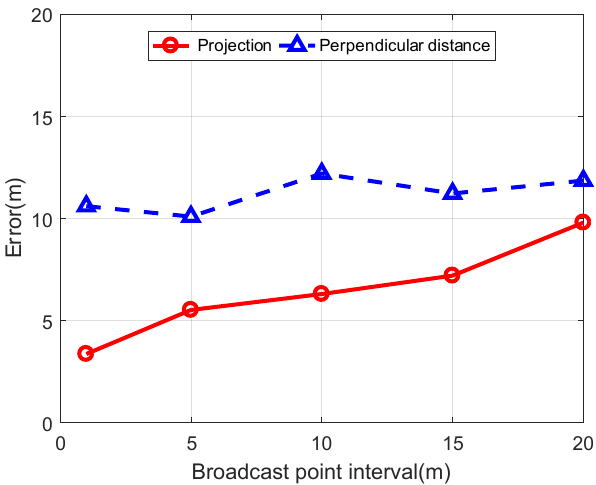
Figure 15. Comparison of mean error between node projection and Perpendicular distance.